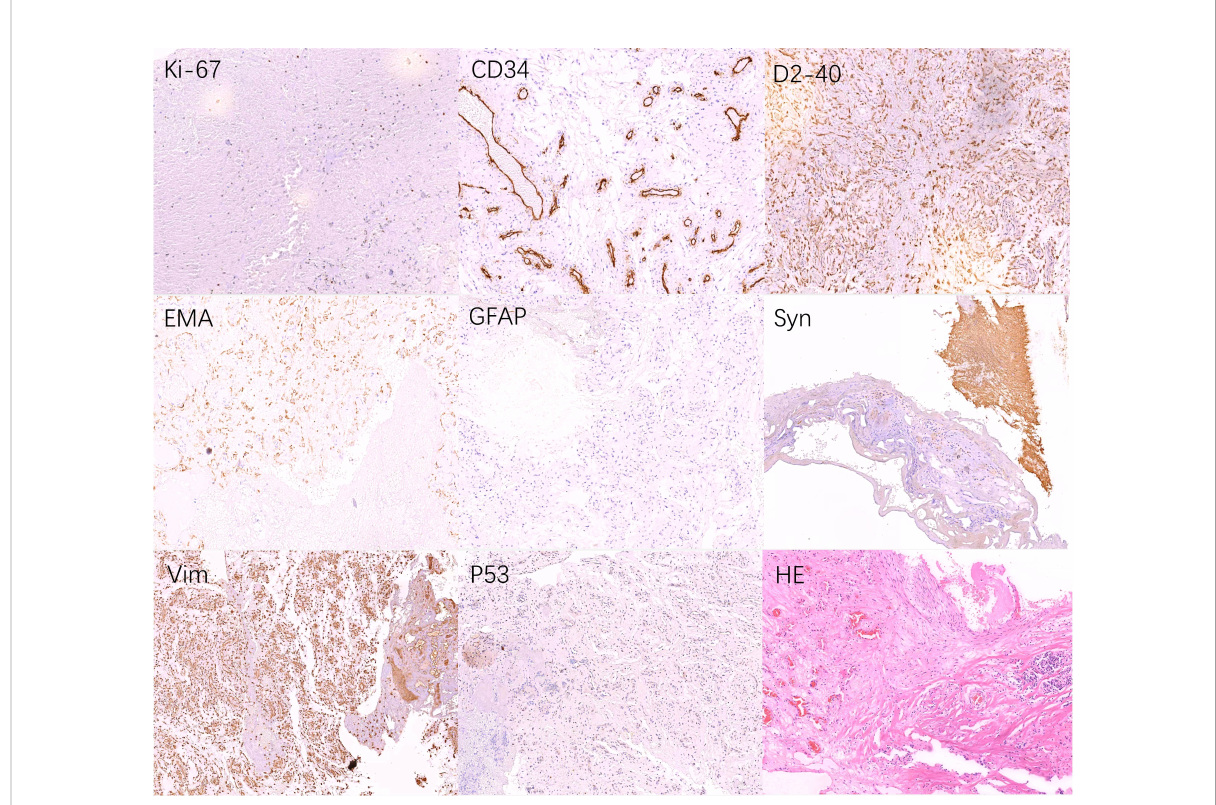
FIGURE 3 Pathological examination after surgery. Tumors were composed of capillaries and stromal cells of different maturation stages, some of which are mildly atypical, we considered hemangioblastoma (WHO grade I) as the fi nal diagnosis. Tumor tissue: Ki-67(2%+), P53(<1%+), CD56(-), NSE (-), Syn(+), EMA(+), CgA(-), PR(-), SALL4(-), GFAP(+\-), S-100( – ), CKpan(-), Vim(+), Myoglobin(-), CD34(Endothelial cells+), D2-40(+), TTF-1(-), Inh- a (-),